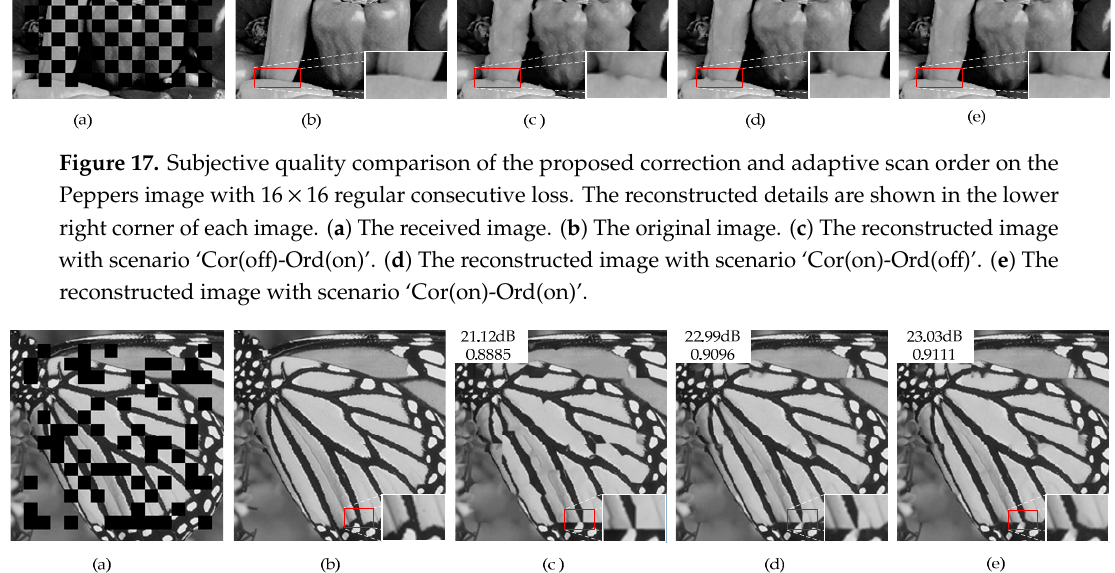
Figure 18. Subjective quality comparison of the proposed correction and adaptive scan order on the Butterfly image with 16 × 16 random loss. The reconstructed details are shown in the lower right corner of each image. ( a ) The received image. ( b ) The original image. ( c ) The reconstructed image with scenario ‘Cor(off)-Ord(on)’. ( d ) The reconstructed image with scenario ‘Cor(on)-Ord(off)’. ( e ) The reconstructed image with scenario ‘Cor(on)-Ord(on)’.